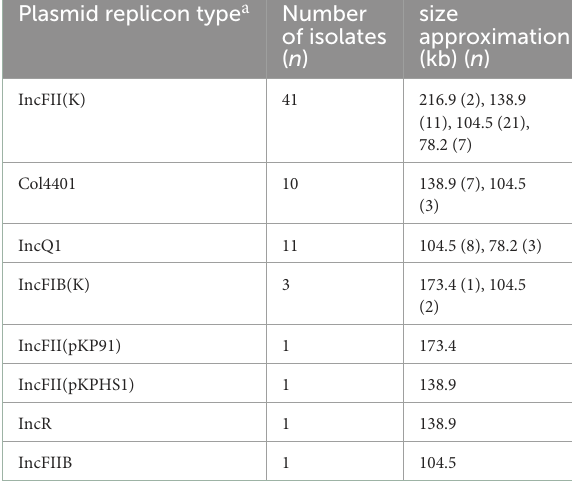
TABLE 1 Analyses of the plasmids for bla CTX − M − 3 -positive K. pneumoniae . Plasmid replicon type